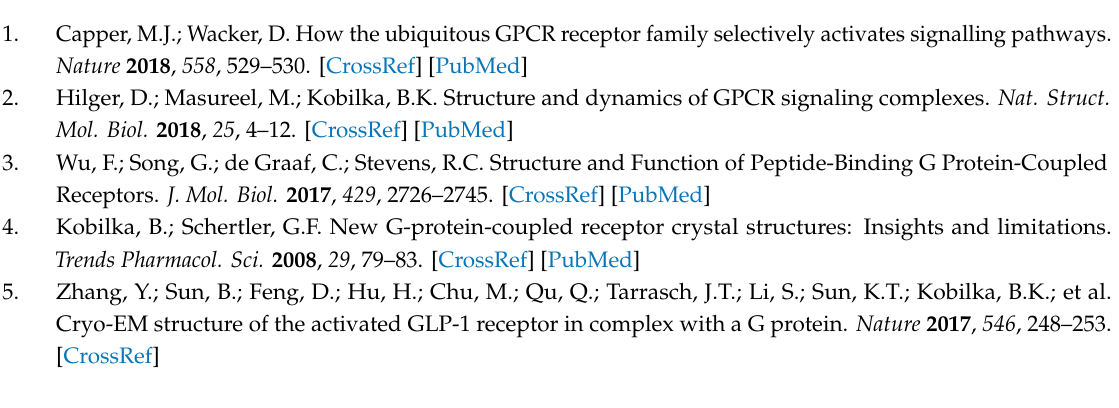
for cysteine introduction. Figure S3: Detailed characterization of Y2R Cys-dpl + R6.29C / R6.30C. Figure S4: Room temperature X-band EPR spectra of the used spin labels in NaP bu ff er. Figure S5 (a–c): Room temperature X-band EPR spectra of the single mutants labeled with MTSL and IDSL in the presence and absence of NPY ligand for (a) intracellular, (b) extracellular and (c) transmembrane positions. Figure S6: Overlaid low temperature (100K) Q-band CW-EPR spectra of the two extracellular and 22 transmembrane positions and labeled with MTSL in the presence and absence of the NPY ligand. Figure S7: Room temperature CW-EPR experimental (black) and simulated (red) spectra of double mutants, 24 labeled with IDSL. With and without the NPY ligand. Figure S8: DEER measurements of the Y2 receptor at di ff erent o ff sets in the presence of NPY at 40MHz. Figure S9: The influence of uncertainties of the background correction and dimensionality on the distance 27 distributions in the presence and absence of NPY ligand at di ff erent o ff